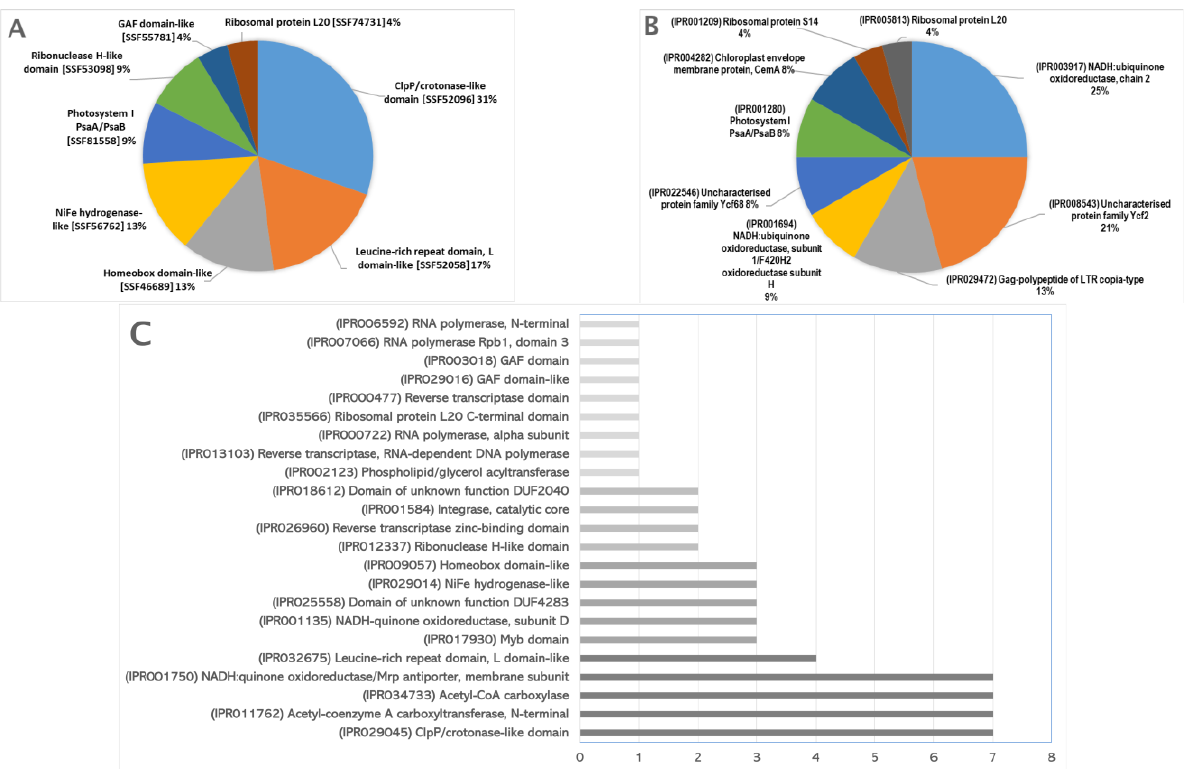
Figure 4. Pie Chart of Main Annotated Proteins and Domains found by BLAS2GO. ( A ) Super-Family Protein; ( B ) Family Protein; ( C ) Domains.